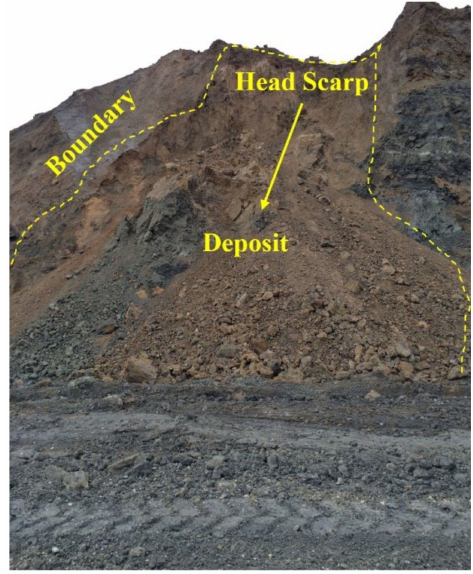
Figure 12. Site image of the landslide.